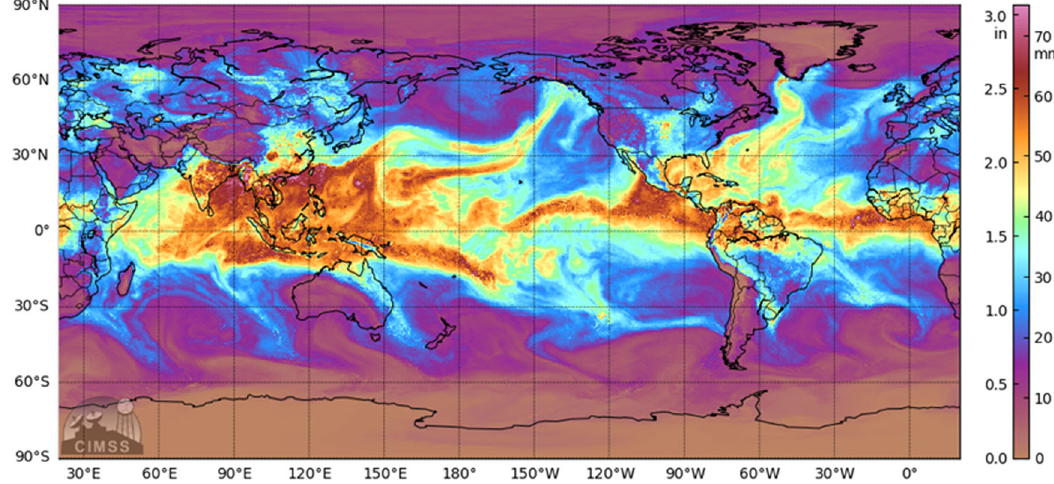
Fig. 1 Morphed integrated microwave total precipitable water (MIMIC-TPW2) 18 valid at 0600 UTC 24 June 2021. The image shows an atmospheric river with origin in Southeast Asia moving across the North Paci fi c and making landfall over Southeast